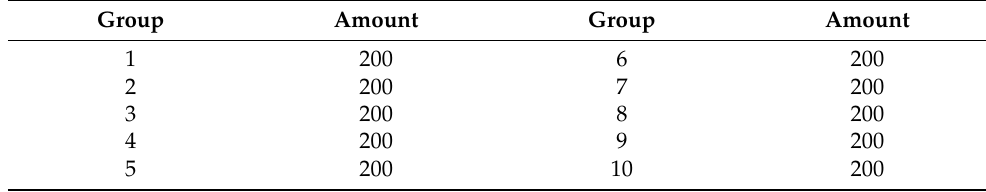
Table 3. K-Folds cross-validation.